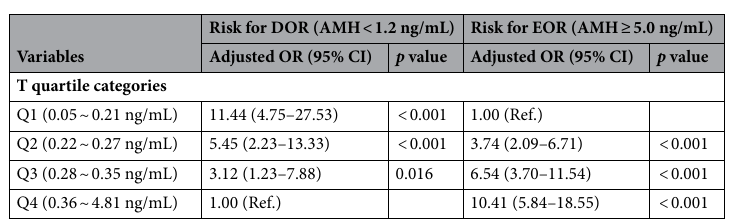
Table 3. Risk for diminished ovarian reserve (DOR) or excess ovarian reserve (EOR) according to serum testosterone quartile categories. ORs (95% CI) for DOR or EOR according to serum testosterone quartile categories after adjustment for multivariate confounders in infertile women (n = 1,935). Binary logistic regression analysis was performed. Multivariate confounders included age, weight, body mass index, and FSH. T testosterone, AMH anti-Müllerian hormone, OR odds ratio, CI confidence interval, Q quartile, Ref. reference.